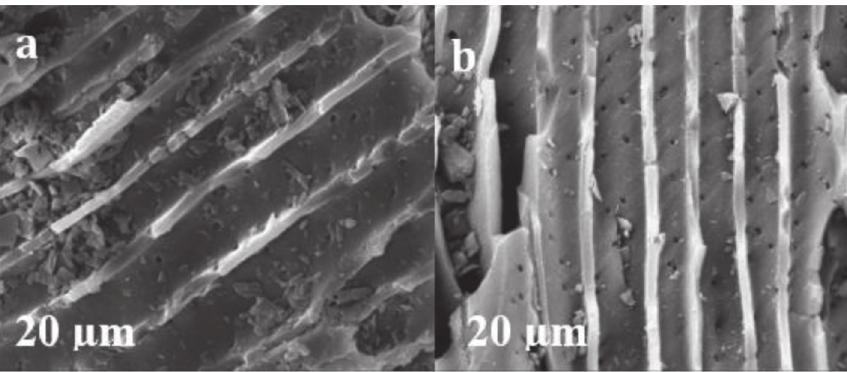
Figure 2: SEM Images of (a) raw groundnut shell biochar; (b) RY145 dye-adsorbed biochar. Table 1: FTIR spectra of raw groundnut shell biochar and dye-adsorbed biochar. Type of vibration